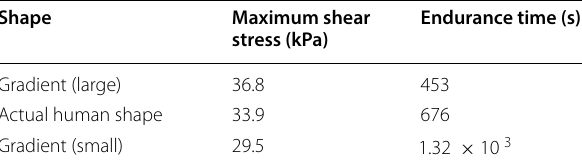
Table 3 Change of safety condition caused by the change of shapes under the 50 N indentation